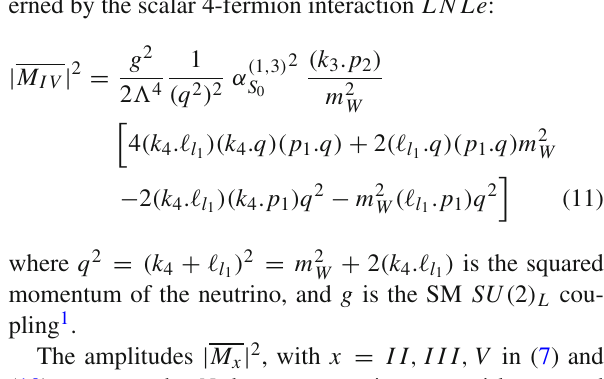
C 3 and C 4 will contribute to right-polarized ( + )